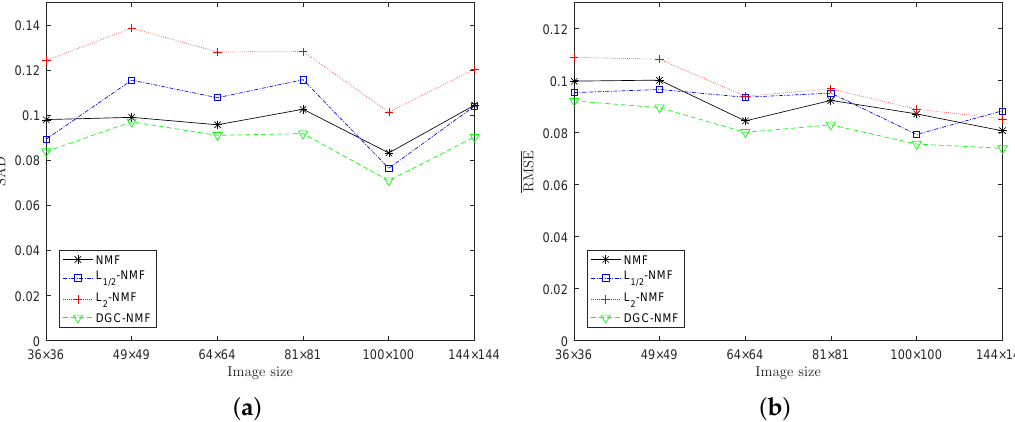
Figure 8. Performance comparison of the algorithms with respect to the different sizes of images. ( a ) SAD; ( b )